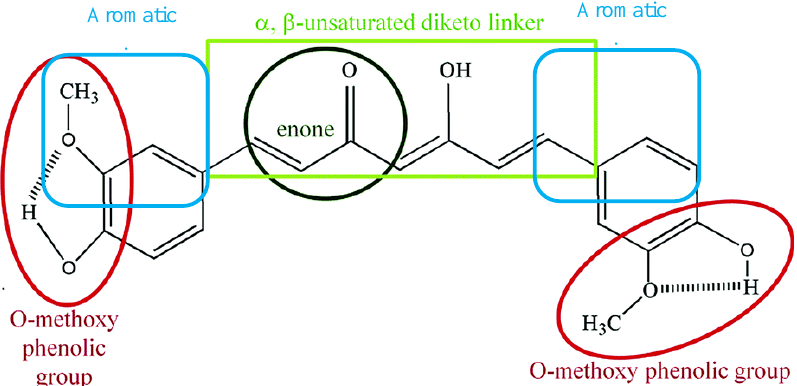
Figure 2. Chemical structural groupings that are responsible for the antioxidant properties of curcumin. Curcumin is composed of three chemical entities: two aromatic ring systems containing O -methoxy phenolic groups linked by a seven-carbon linker containing of α , β -unsaturated diketone moiety.